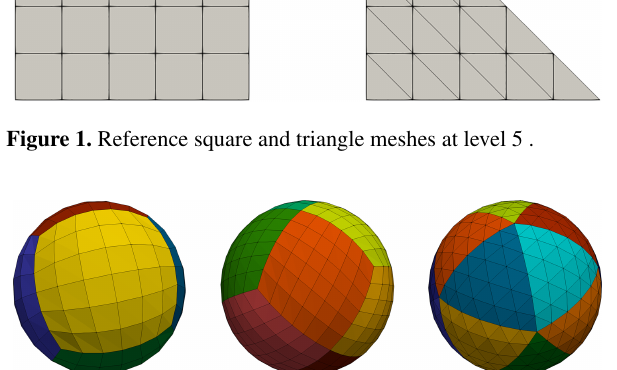
Figure 3. (a) HS06 mesh composed of 6 blocks containing each 6 3 cells; (b) HS12 mesh composed of 12 blocks containing each 6 3 cells; (c) HS20 mesh composed of 20 blocks containing each 6 3 cells.